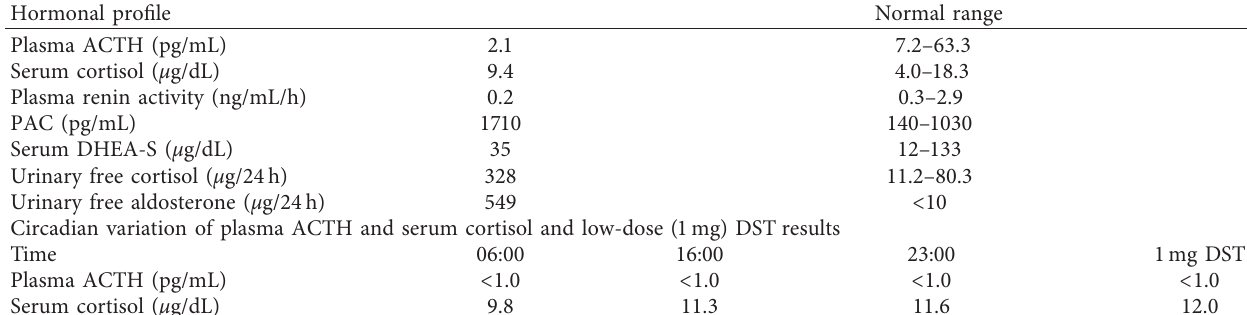
Table 2: Endocrinological examination.